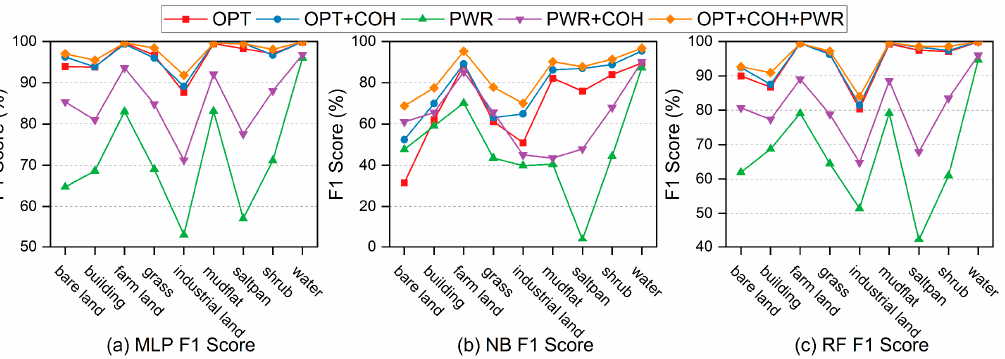
Figure 9. F1 score (%) for different land cover types using different datasets and supervised classification methods.